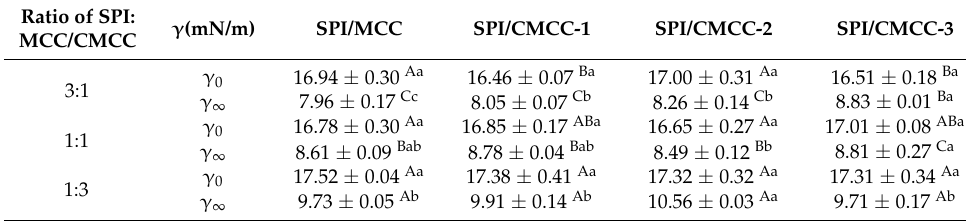
Table 2. The initial interfacial tension ( γ 0 ) and steady-state interfacial tension at equilibrium ( γ ∞ ) of soybean oil/water interfaces as stabilized by complexes of SPI and MCC/CMCC at different ratios. Ratio of SPI: MCC/CMCC